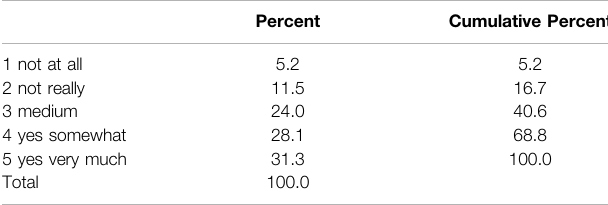
TABLE 1 | Percent of players reporting ef fi cacy of the interactive “ probability of infection bar. ”